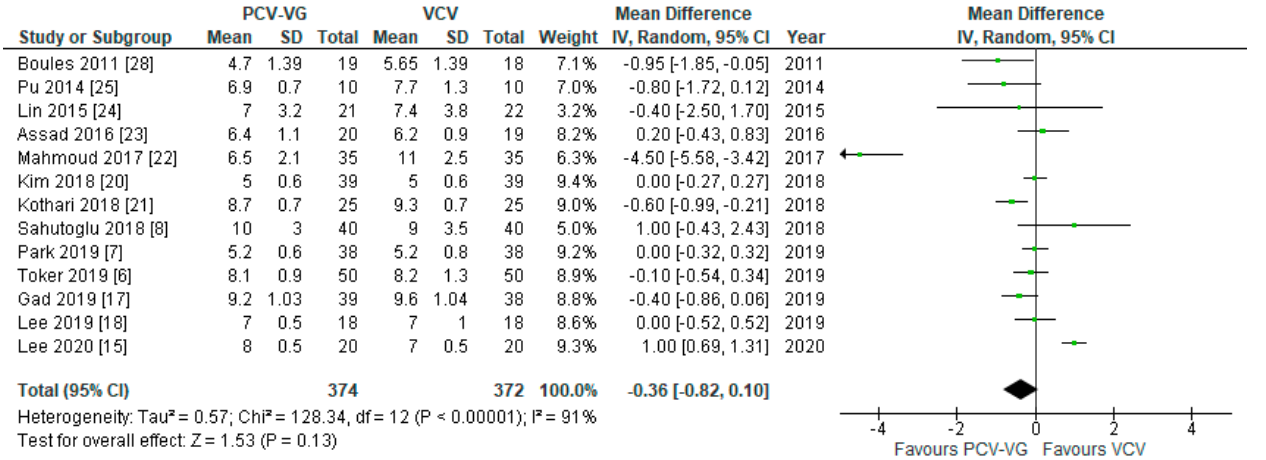
Figure 5. Plateau airway pressure (P plateau ): supine, two-lung ventilation. The green center of each square represents the weighted mean difference for individual trials, and the corresponding horizontal line stands for a 95% confidence interval. The diamonds represent pooled results.